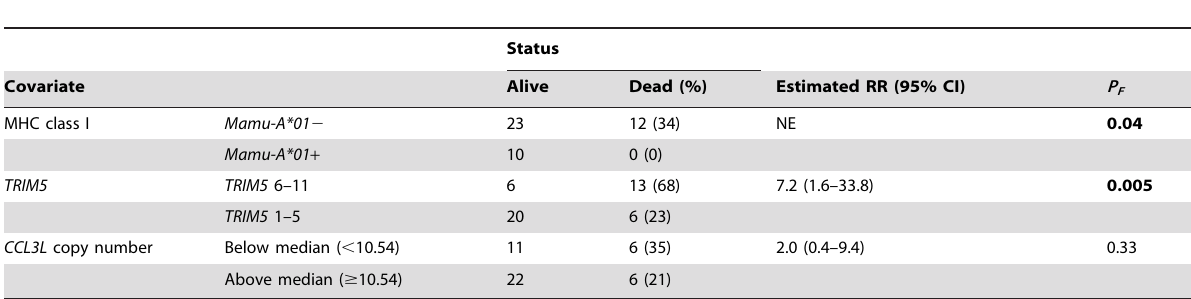
Table 4. Analysis of the survival status on day 235 following SIVmac251